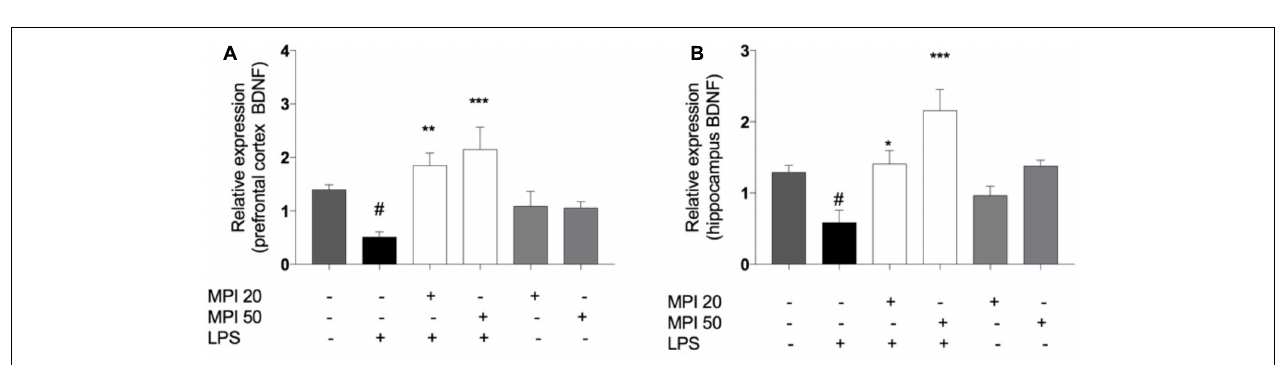
FIGURE 7 | p65 NF κ B expression in (A) PFC and (B) HC of LPS-induced group mice increased significantly when compared to the control group ### P < 0.001. MPI (20–50 mg/kg) followed by LPS administration prevented the increase of NF κ B expression in (A) PFC ( F 5 , 30 = 30.45, P < 0.001 post hoc ∗∗∗ P < 0.001, n = 6) and in (B) HC ( F 5 , 30 = 31.82, P < 0.001, post hoc ∗∗∗ P < 0.001, n = 6) ( ∗∗∗ ) when compared to the LPS-induced group. No significant differences observed among the control and MPI followed by saline admnistration. Data were analyzed using a one-way ANOVA followed by the Student–Newman–Keuls multiple comparisons post hoc test. Error bars represent SEM.